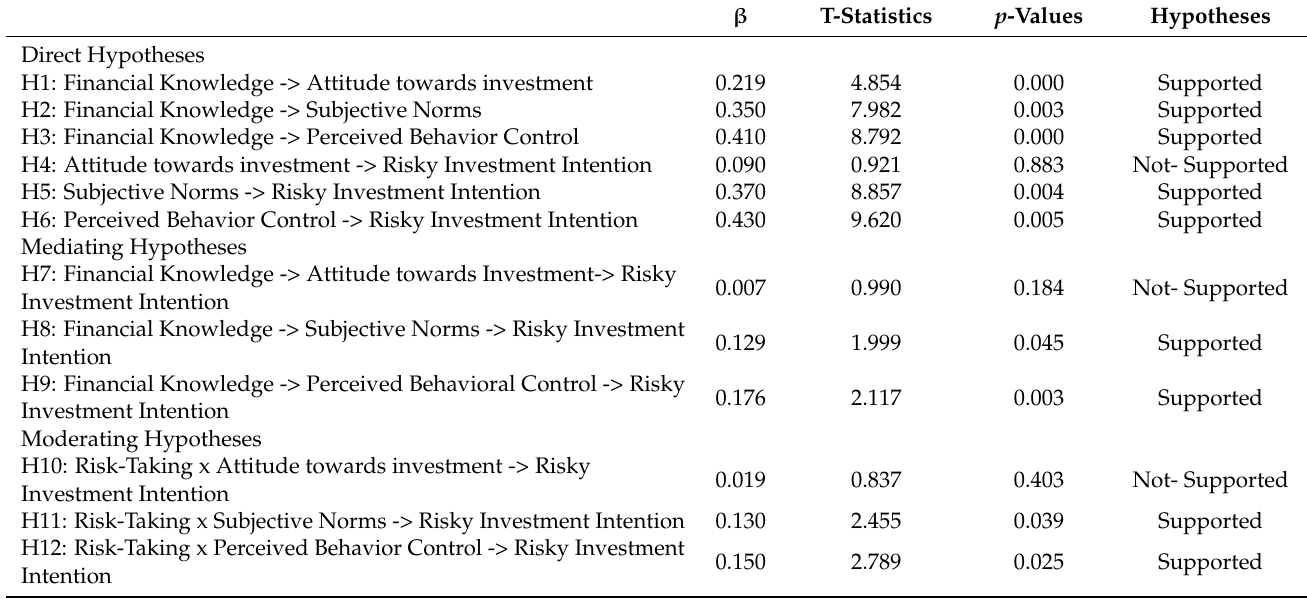
Table 5. The inner model’s findings.